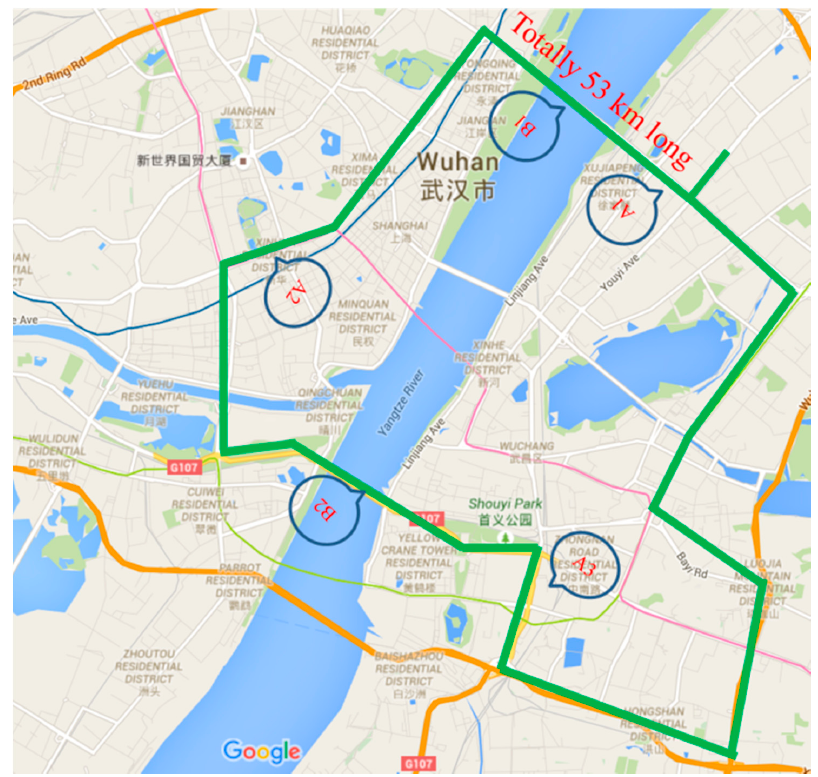
Figure 5. The test route.